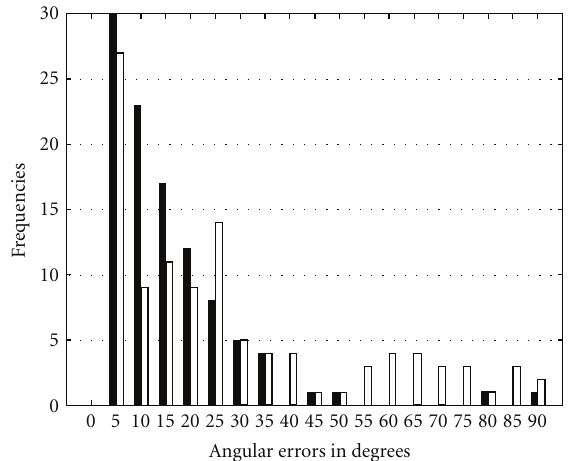
Figure 3: Frequencies of angular errors (deg) performed in aligned (black) and misaligned (white)